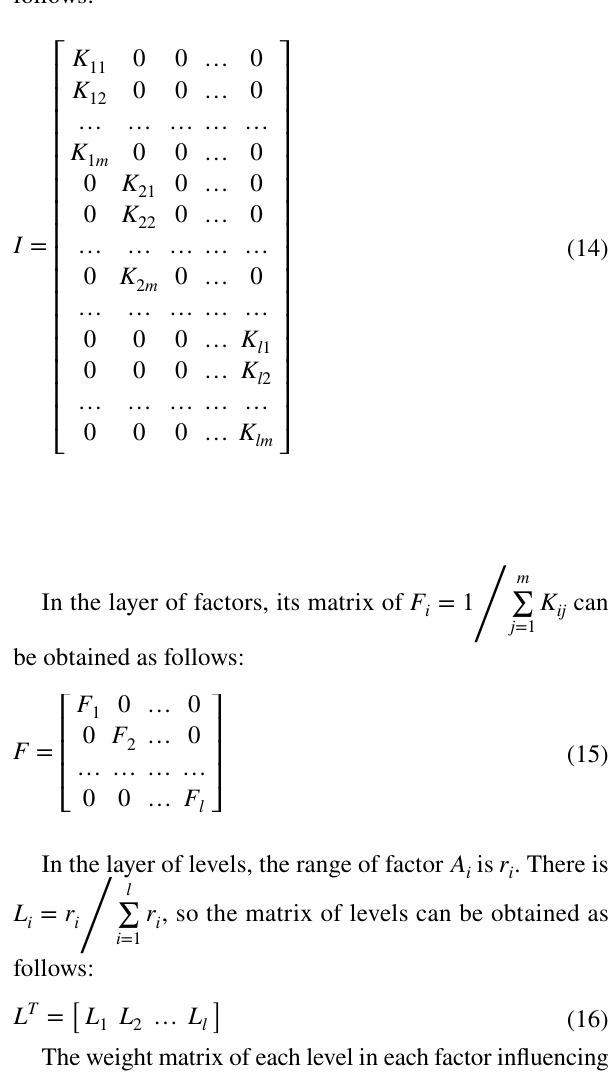
Table 2 Evaluation of each factor under different levels